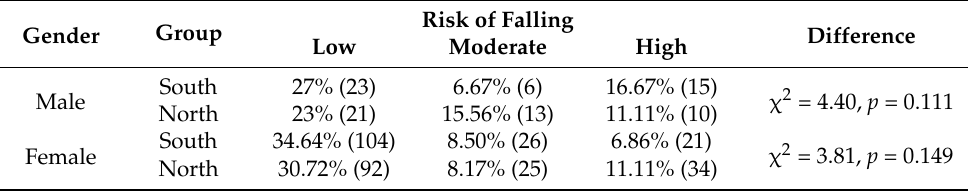
Table 2. Risk of falling frequencies in% (and absolute) of the sample per gender.